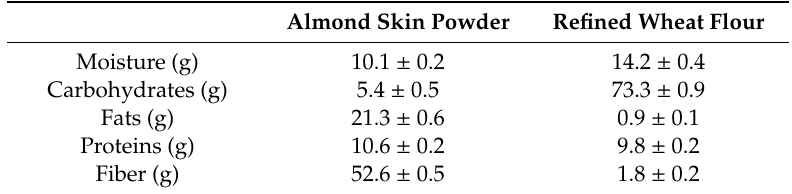
Table 3. Nutritional composition of dried almond skin powder and wheat flour used in the preparation of experimental biscuits. Values per 100 g, expressed on fresh weight